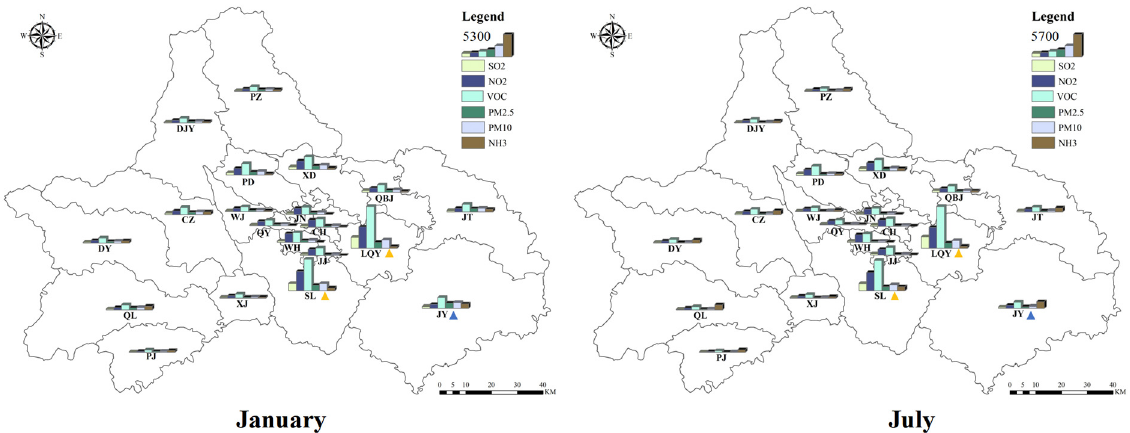
Figure 4. Emission distribution map of air pollutants in various regions of Chengdu (unit: t); the districts include Chenghua District (CH), Chongzhou City (CZ), Dayi County (DY), Dujiangyan (DJY), Jianyang City (JY), Jinniu District (JN), Jintang County (JT), Jinjiang District (JJ), Longquanyi District (LQY), Pengzhou City (PZ), Pidu District (PD), Pujiang County (PJ), Qingbaijiang District (QBJ), Qingyang District (QY), Qionglai City (QL), Shuangliu District (SL), Wenjiang District (WJ), Wuhou District (WH), Xindu District (XD), Xinjin District (XJ).